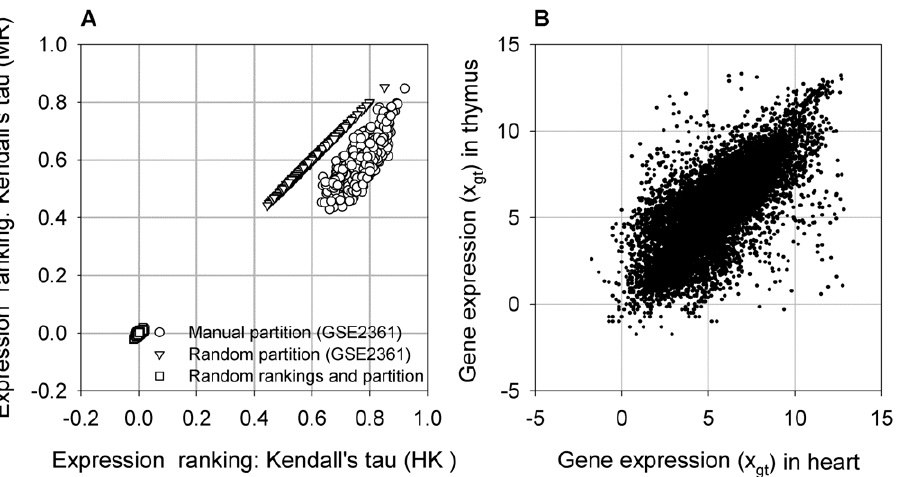
Figure 2. Ranking preservation of HK genes was not a random event. (A) Kendall’s tau computed for the manually partitioned HK and MR genes (circles) compared to those generated from two different random distributions: the triangles show the results when the GSE2361 expression data were randomly divided into two sets containing the same number of HK ( N g =388) and MR ( N g =11,953) genes, while the squares show the results when expression levels were ignored and rankings were randomly created (see Methods). Each data point is a combination of the two (cid:2) tt tt 0 computed for the two gene groups ( N g =388 and N g =11,953) for a particular pair of tissues. (B) The expression of all the genes in any two human tissues (heart and thymus are shown as an example) always has an elliptical shape, resulting in a substantially preserved ranking order with a non- zero (cid:2) tt tt 0 ( . 0.4) even for randomly grouped genes (triangles in (A)). In contrast, randomly assigned rankings would yield a (cid:2) tt tt 0 value very close to zero (squares in (A)). Gene expression levels were log2 transformed and were denoted by x gt .